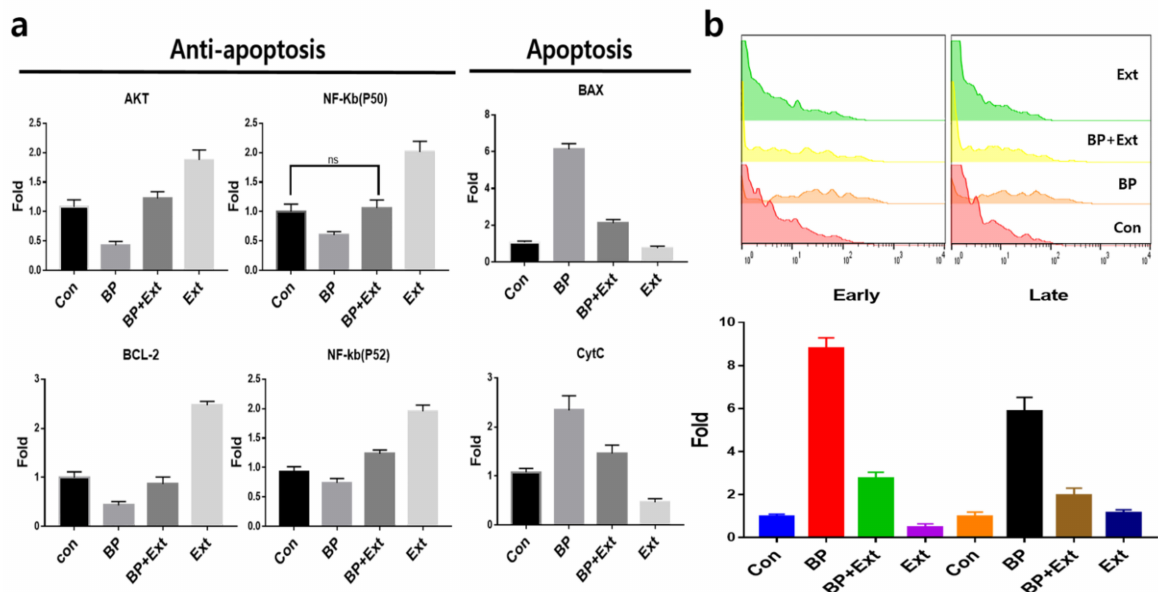
Figure 2. Diameters of particles in the grinded black jade. Distributions of particle size in one and two cycles of heating and grinding. ( a ) Red dotted lines indicate the peaks for the particle size of the greatest portion in the black jade particles. ( b ) Comparison of peak sizes between first and second cycles ( p < 0.05, n = 3).